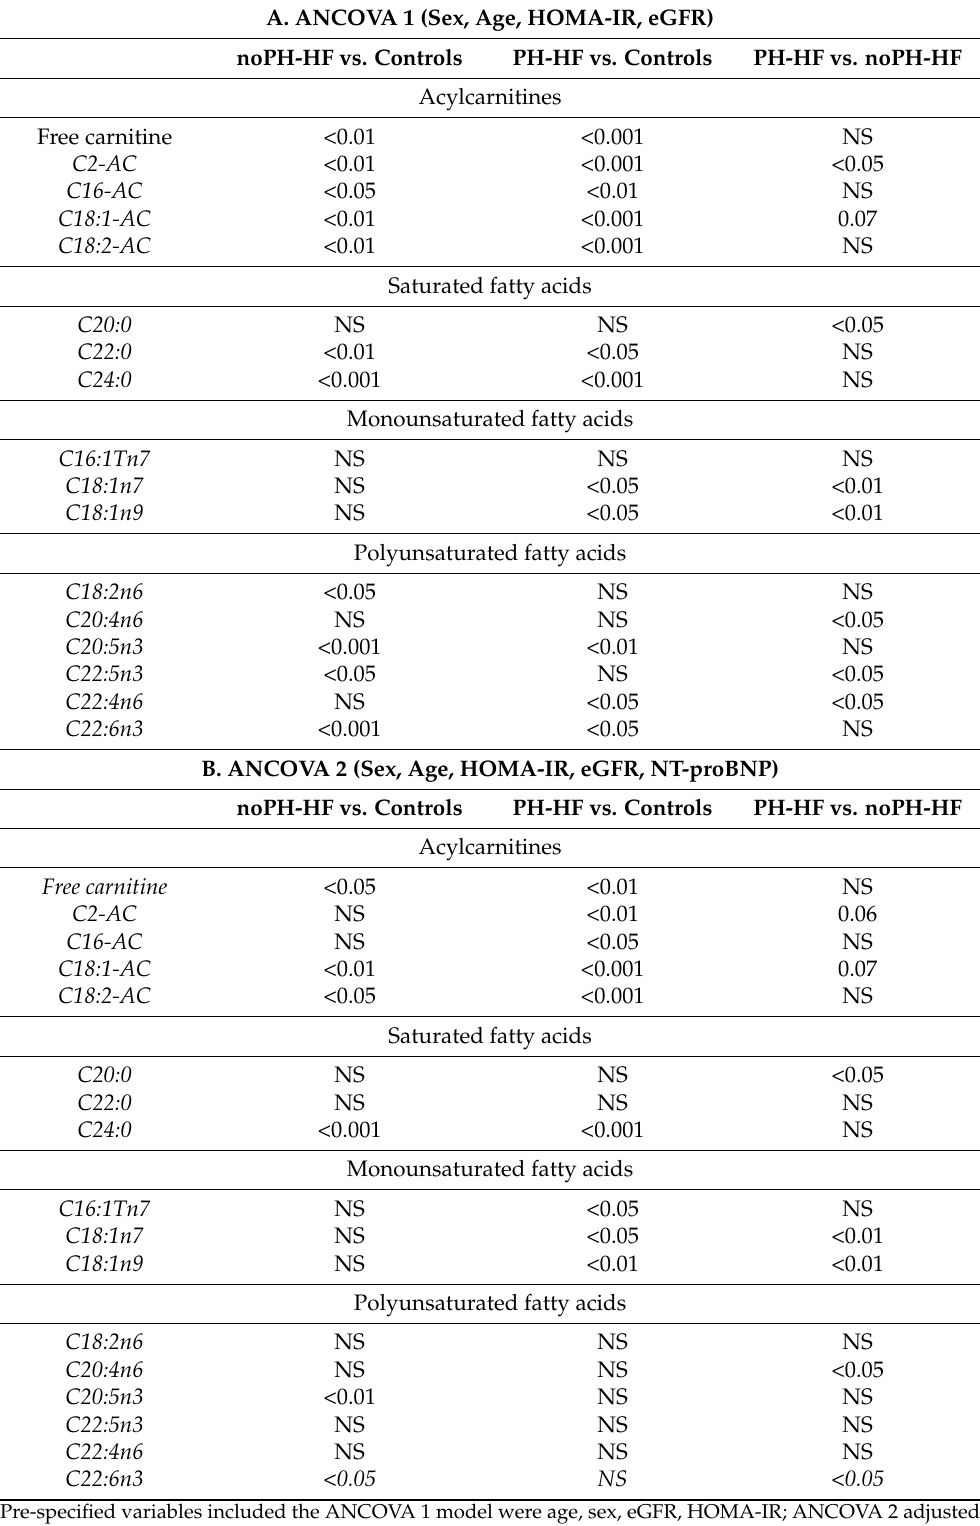
Table 3. Adjusted comparison of circulating acylcarnitine and fatty acid levels among